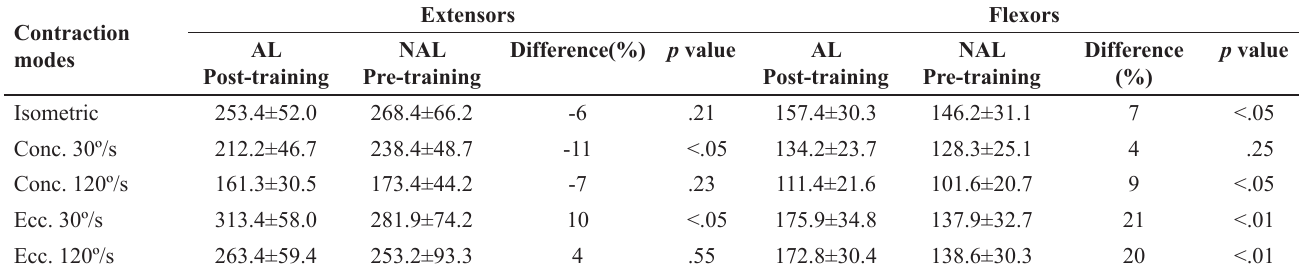
2. Comparison of the values of APT between AL (post-training) and NAL (pre-training) of the knee extensors and flexors.